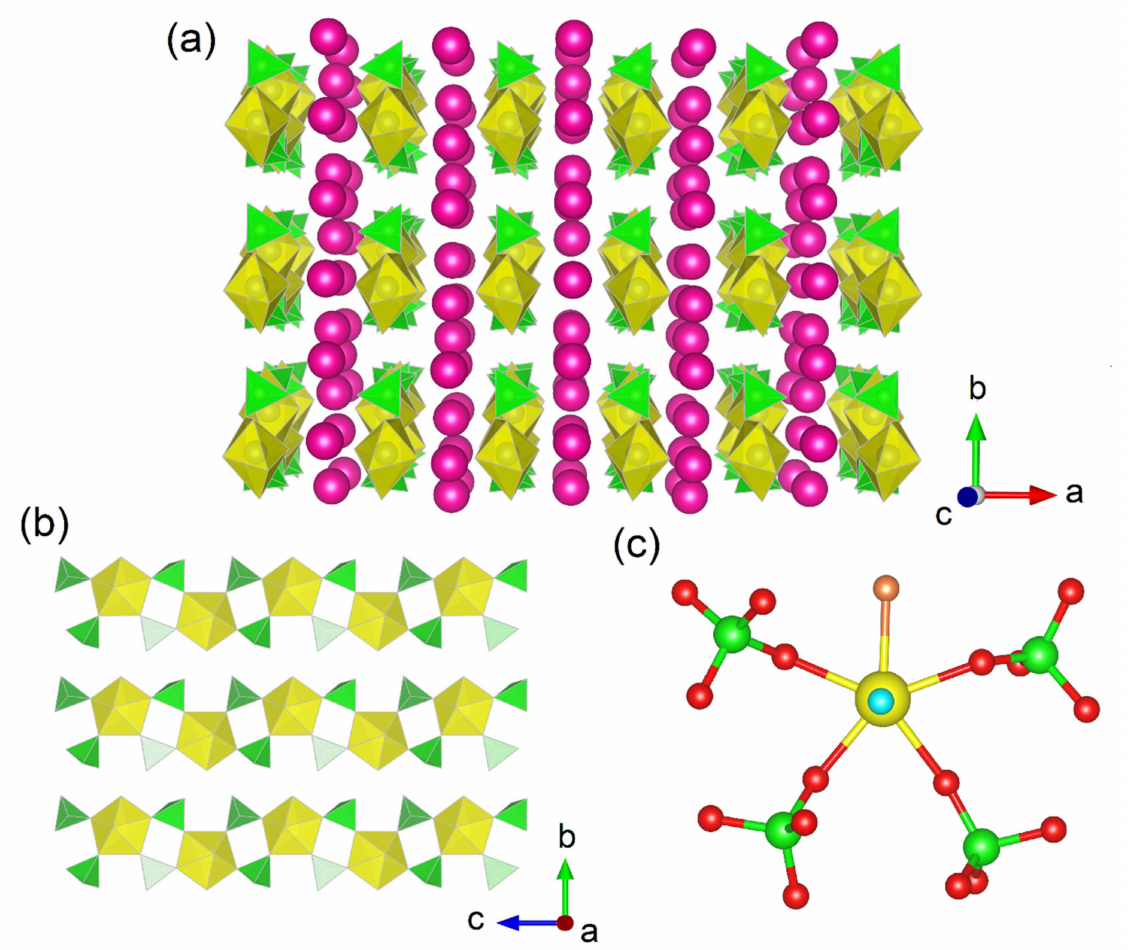
Figure 3. Structural representation of orthorhombic Rb 2 [UO 2 (SeO 4 ) 2 (H 2 O)] · 2H 2 O in space group Pmn 2 1 ( a ) general repre- sentation, ( b ) in the [100] direction illustrating the layer configuration of the structure and ( c ) highlighting the coordination motif of UO 7 and SeO 4 units. Note yellow polyhedra, green polyhedra, green spheres, yellow spheres, red spheres, blue spheres and orange spheres respectively represent UO 7 , SeO 3 , Se, U, O, uranyl O and aqua O units/atoms